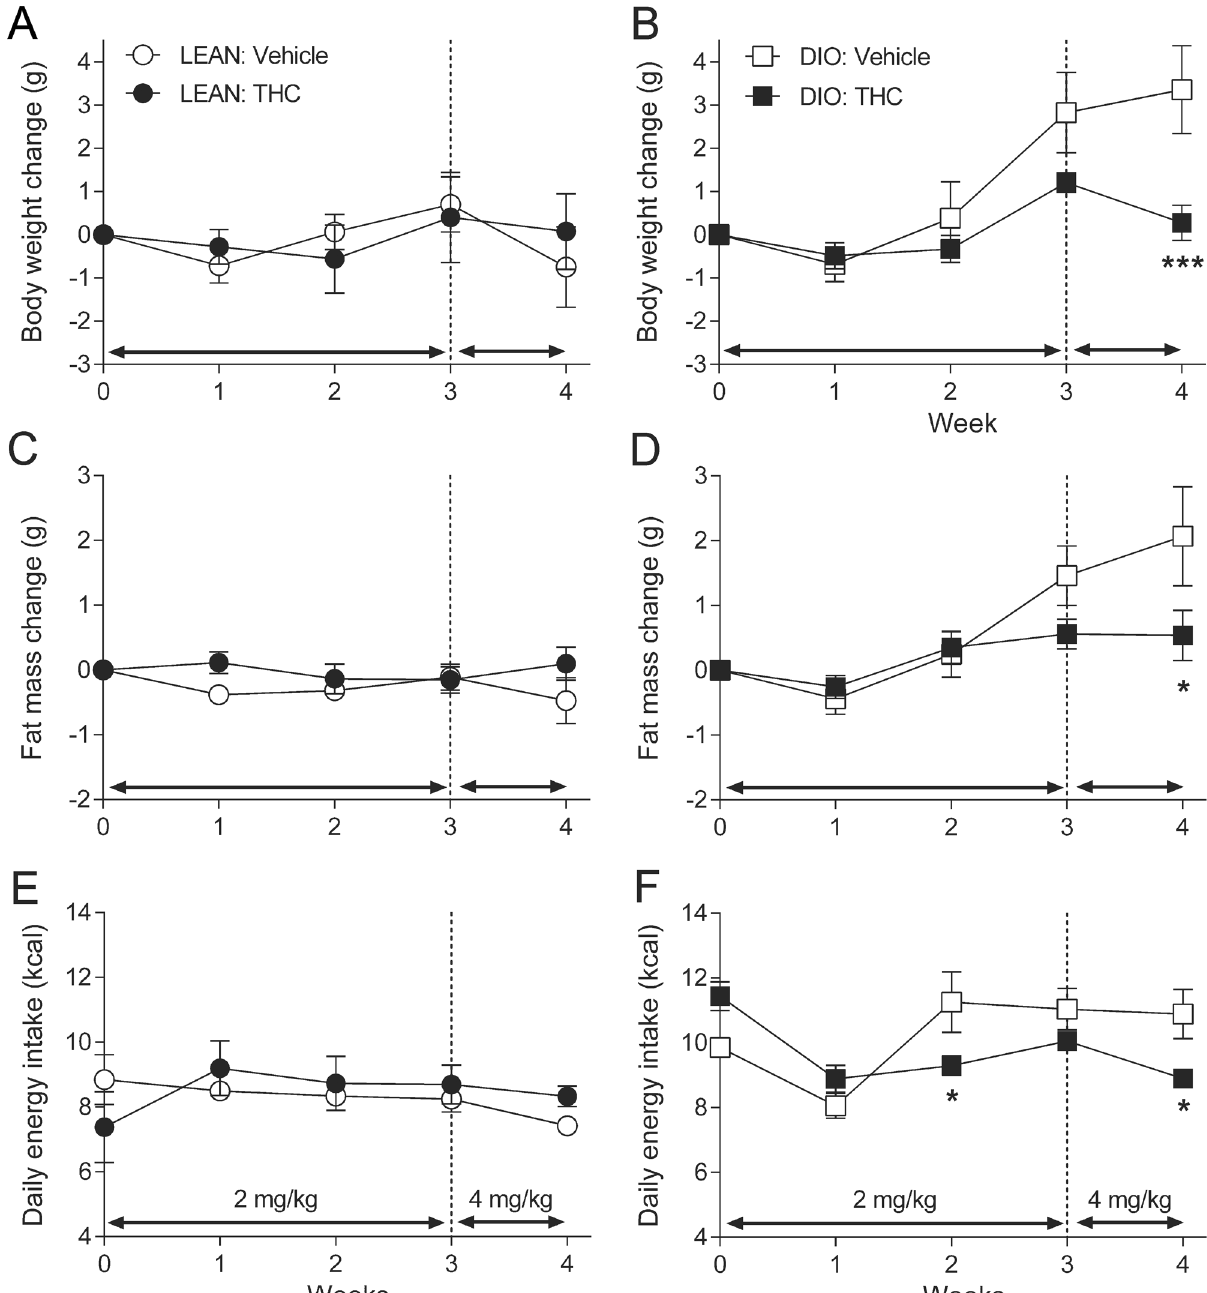
Fig 1. Chronic THC prevents high fat diet-induced change in body weight and fat mass. The effect of daily administration of Δ 9 -tetrahydrocannabinol (THC; 2 or 4 mg/kg) or vehicle on body weight change ( A , B ), fat mass change ( C , D ) and daily energy intake ( E , F ) in lean ( A , C , E ) or diet-induced obese (DIO) mice ( B , D , F ). Data points represent the mean ± s.e.m., n = 5 – 8. * P < 0.05 and *** P < 0.001 denote a significant difference from the vehicle control.